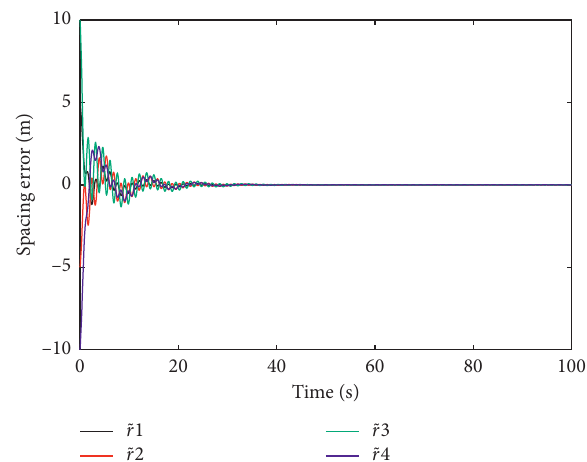
Figure 2: Spacing errors for an automated vehicular platoon under undirected topology with τ � 0 . 31 s.